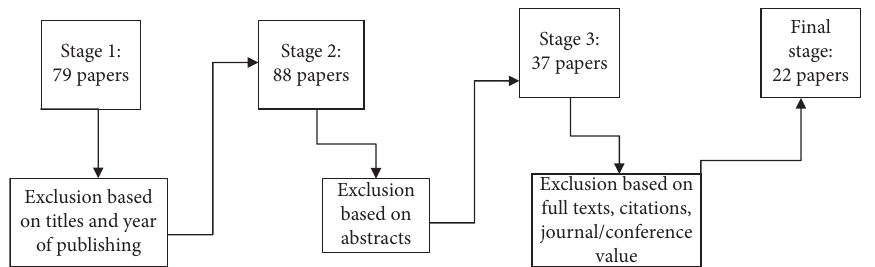
Figure 1: Exclusion criteria for shortlisting of quality and relevant articles.